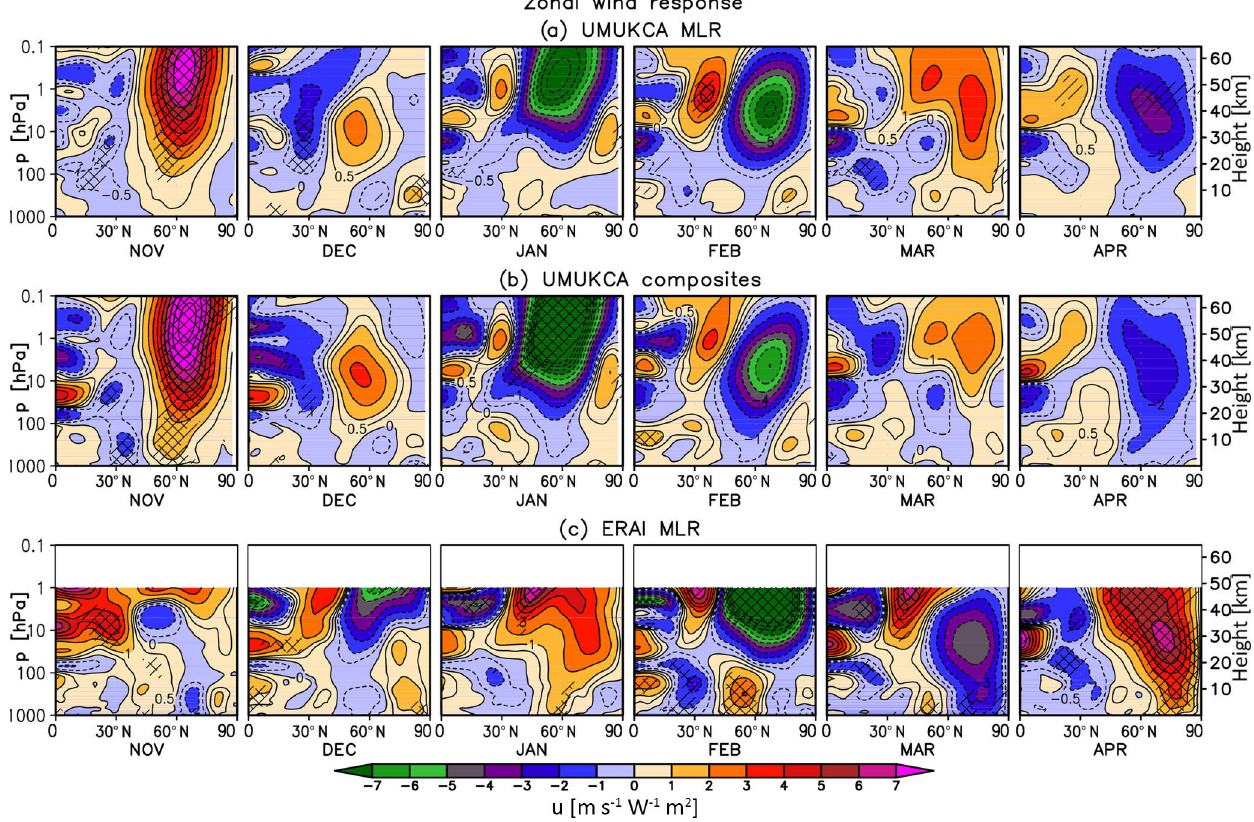
Figure 7. As in Fig. 6 but for the zonal mean zonal wind change (ms − 1 W − 1 m 2 ). Note the additional contours at ± 0 . 5, ± 8, ± 9 and ± 10ms − 1 W − 1 m 2